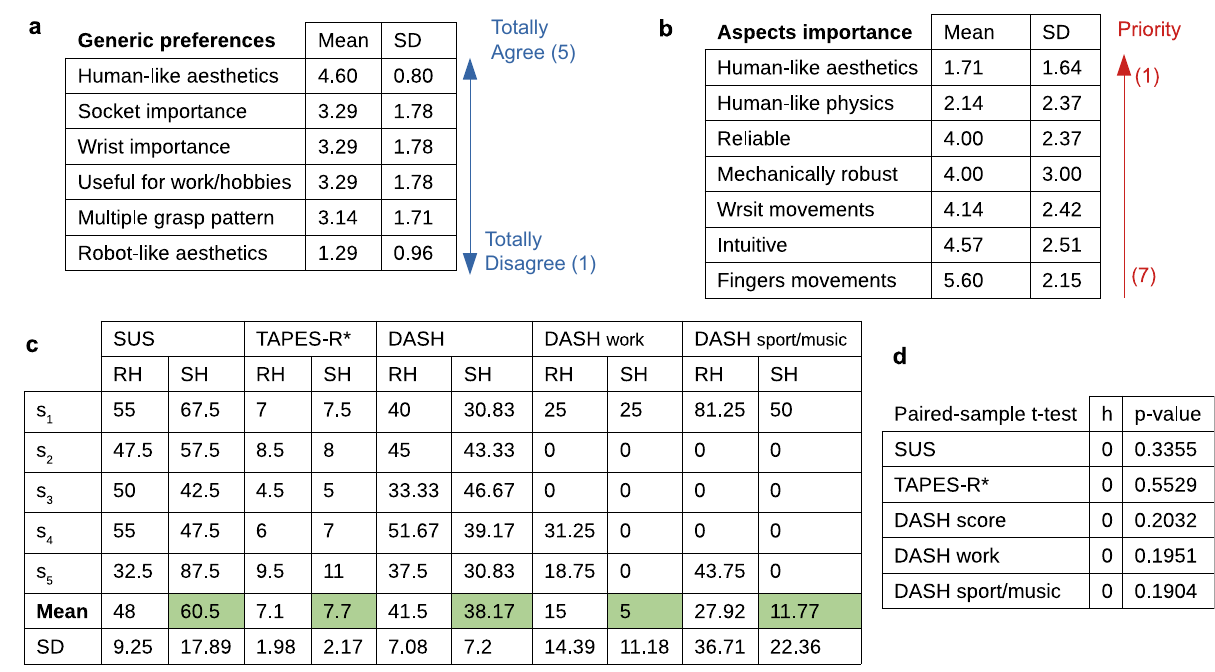
Figure 3. User-perception survey results. ( a ) Shows participants general preferences and ( b ) priorities in prostheses, collected before testing the systems. ( c ) Summarize user-perception scores post-training. RH and SH refer to rigid and soft hands, respectively. In SUS and TAPES-R*, the higher score indicates larger device acceptability and user satisfaction. Contrarily, in the DASH, the lower score indicates less difficulties perceived by the user to perform the included activities (0 represents the minimum score). The higher average positive user-perception is highlighted in green for each survey. ( d ) Presents the statistical analysis for user-perception